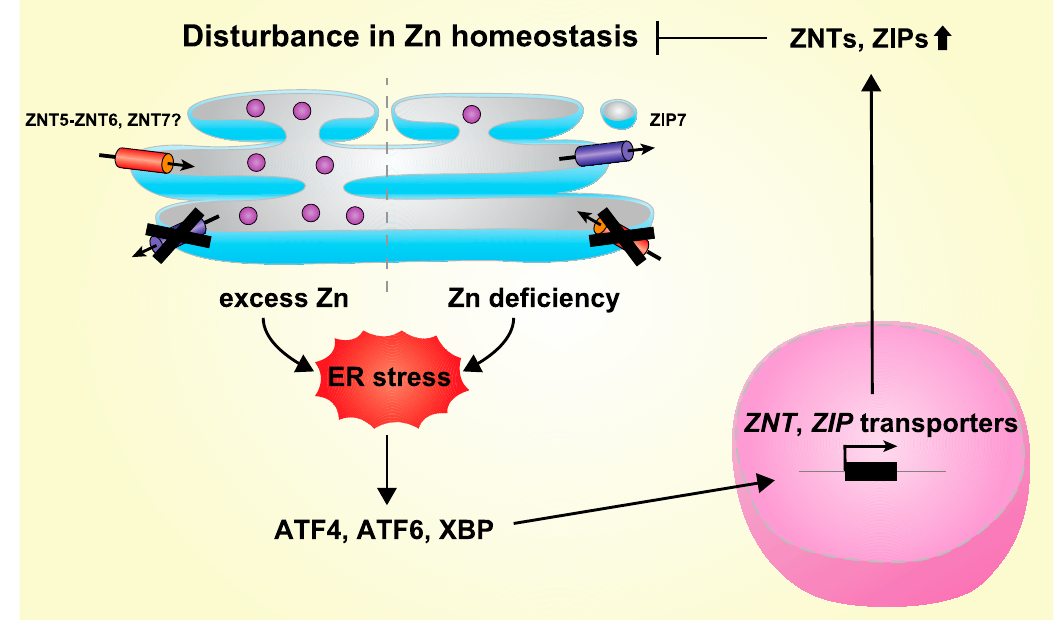
Figure 3. Model of feedback regulation for the maintenance of zinc homeostasis in the ER (in the early secretory pathway). A disturbance in zinc homeostasis, such as zinc deficiency or zinc overload, in the ER (and perhaps in the early secretory pathway) induces homeostatic ER stress. The unfolded protein response (UPR) leads to the activation of transcription factors such as ATF4, ATF6, and XBP1, and increases the transcription of several ZNT and ZIP transporter genes. These activities of ZNT and ZIP transporters then contribute to the maintenance of zinc homeostasis in the ER (and in the early secretory pathway), and thus attenuate homeostatic ER stress. Zn: zinc.